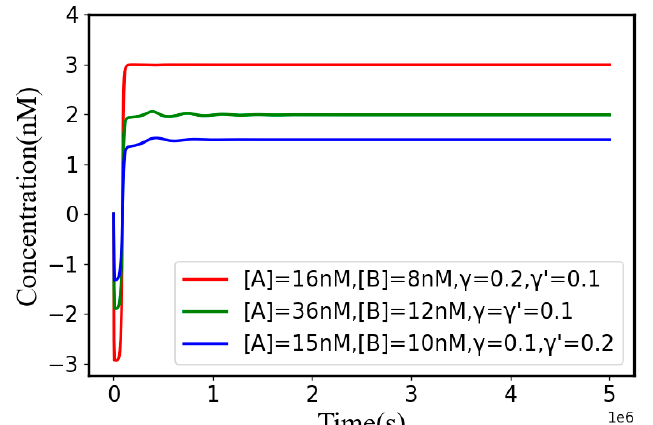
Figure 16. Calculations of the division gate control system when the initial species A and B leak simultaneously. Table 9. The initial species concentrations and leak parameters γ and γ (cid:48) . The Initial Species